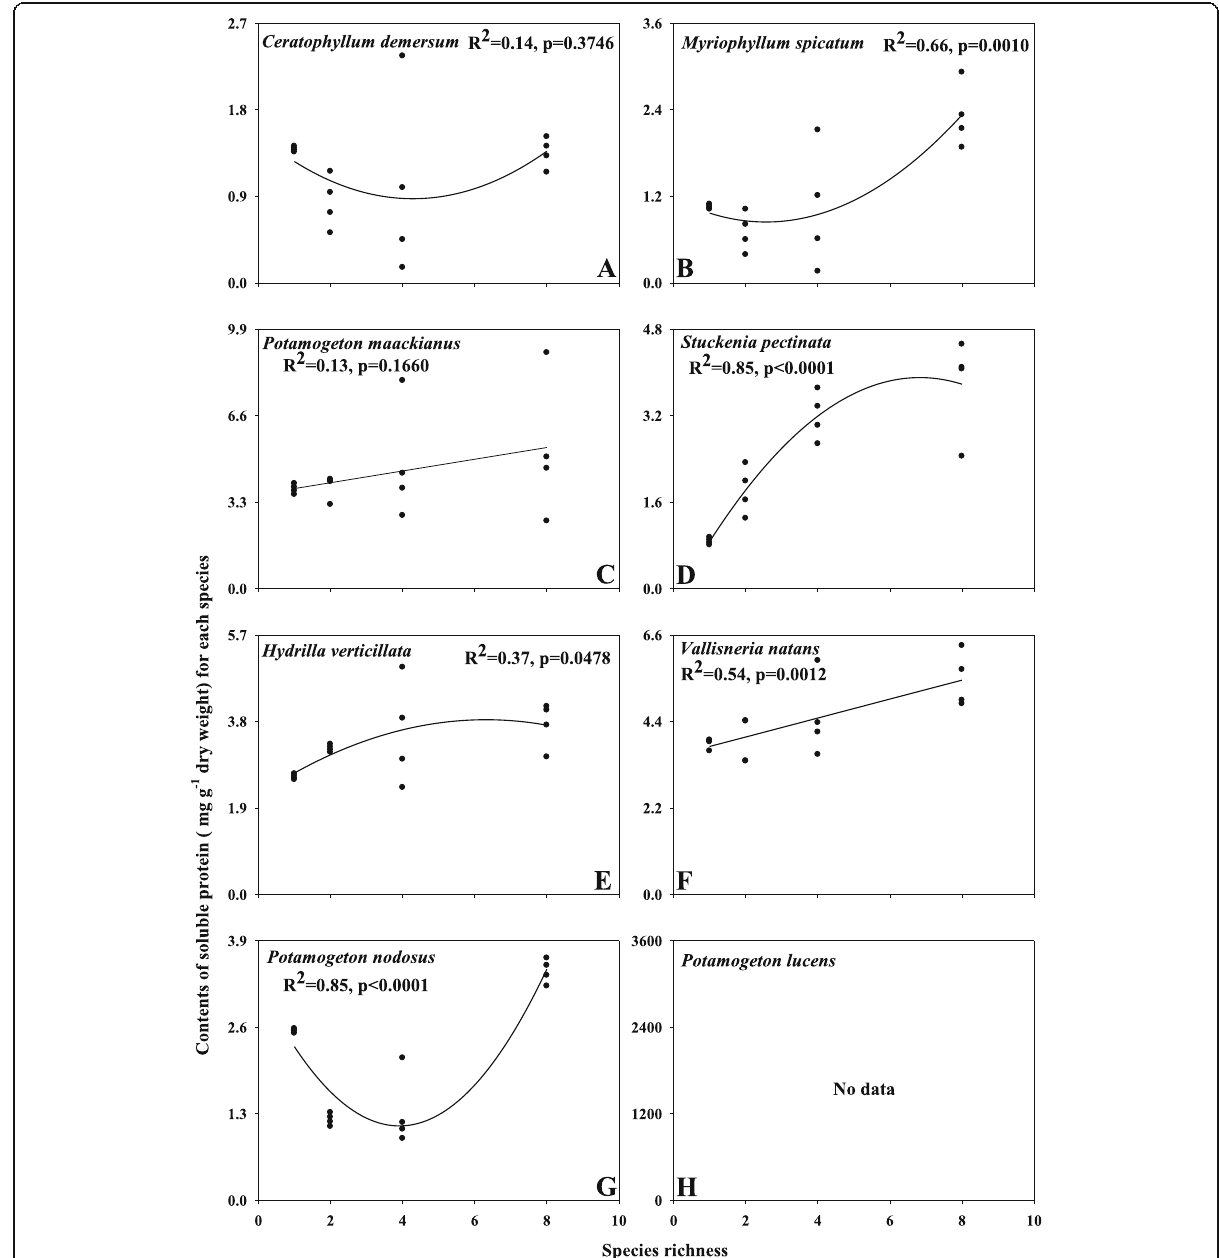
Fig. 3 The plant soluble protein of individual species along an aquatic plant biodiversity gradient in Lake Erhai. Note: No data means that the sample is too small to be measured and the follows are the